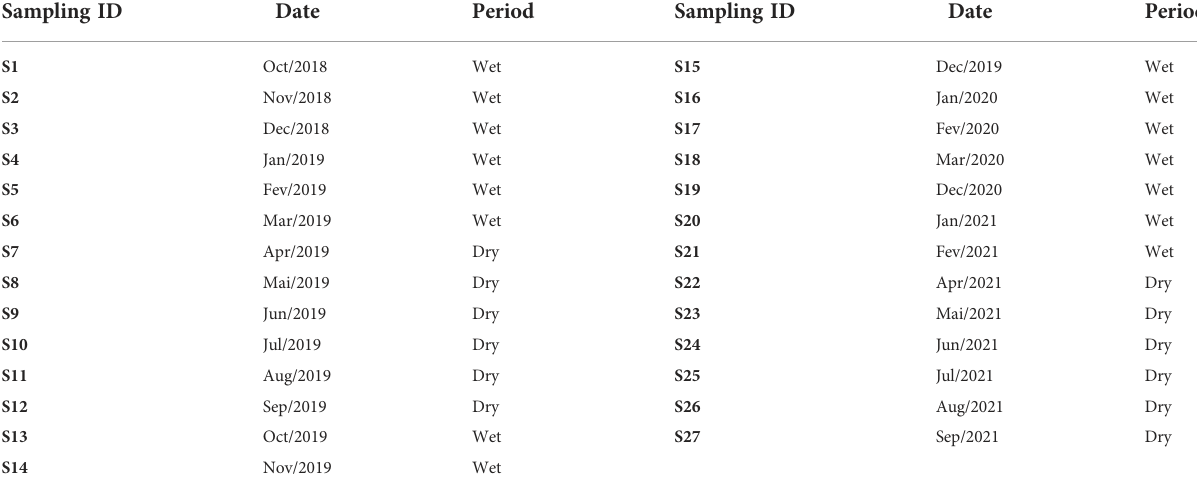
TABLE 1 Summary of sampling